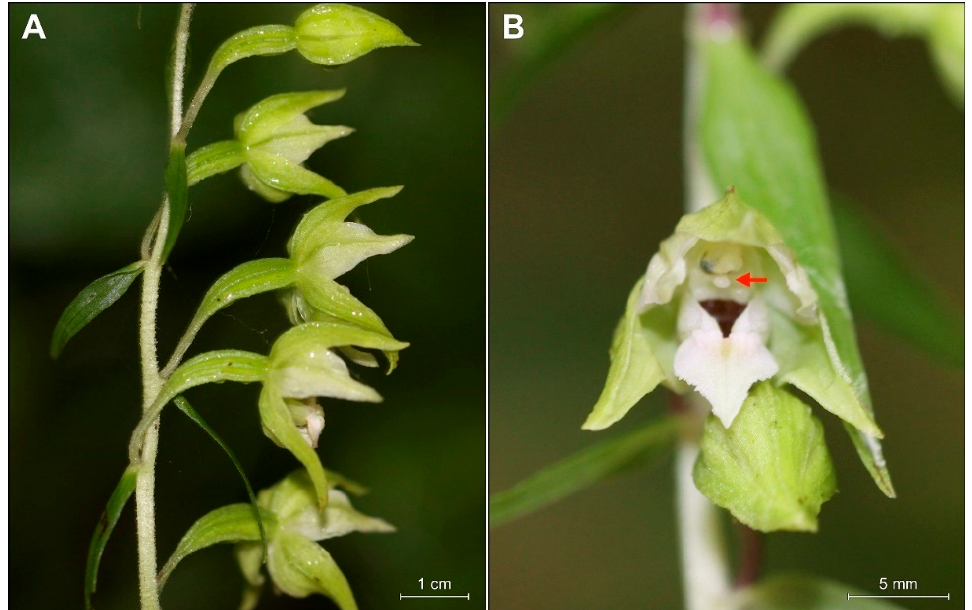
Figure 9. Phenotypical variability of Epipactis helleborine (L.) Crantz. Locality: Siechnice near Wrocław, SW Poland. ( A ) Side view of the inflorescence, please pay attention to long pedicels and narrow ovaries. ( B ) Flower, frontal view. Viscidium is marked with a red arrow. This specimen was prepared as herbarium vouchers presented in Figure 3G.